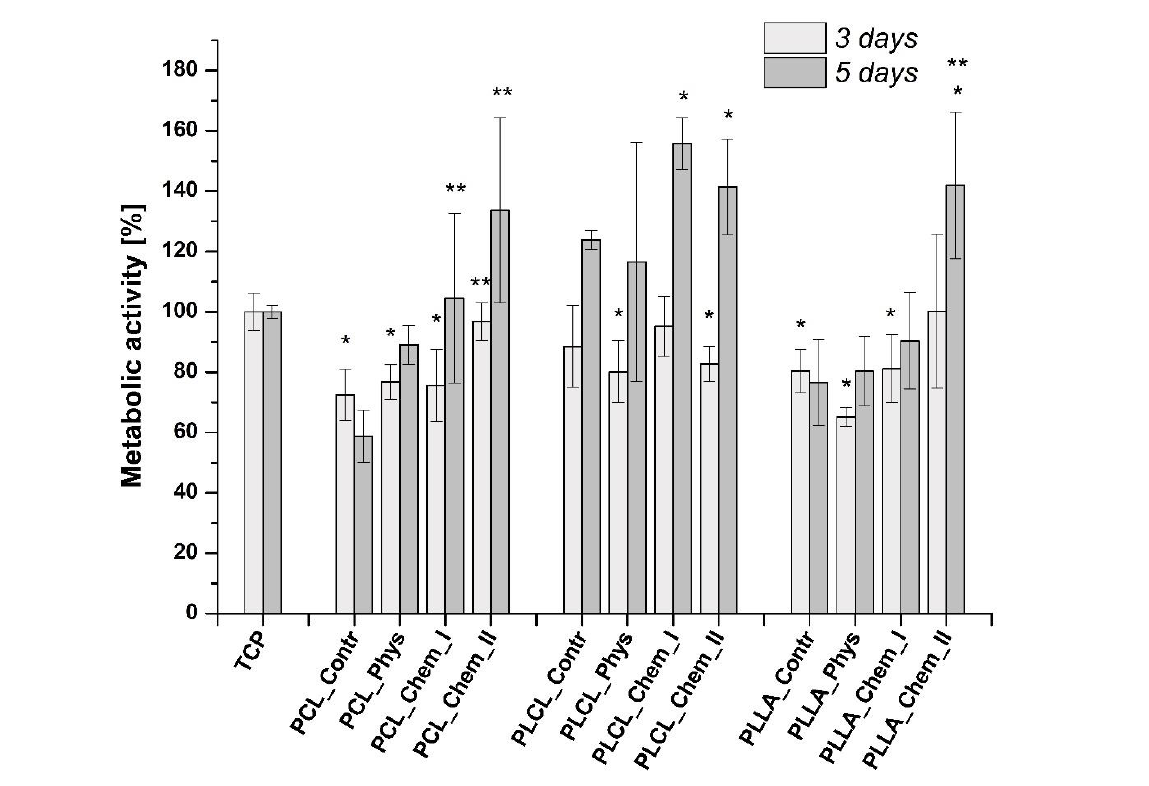
Figure 10. Viability of L929 cells cultured on control and gelatin-coated samples.